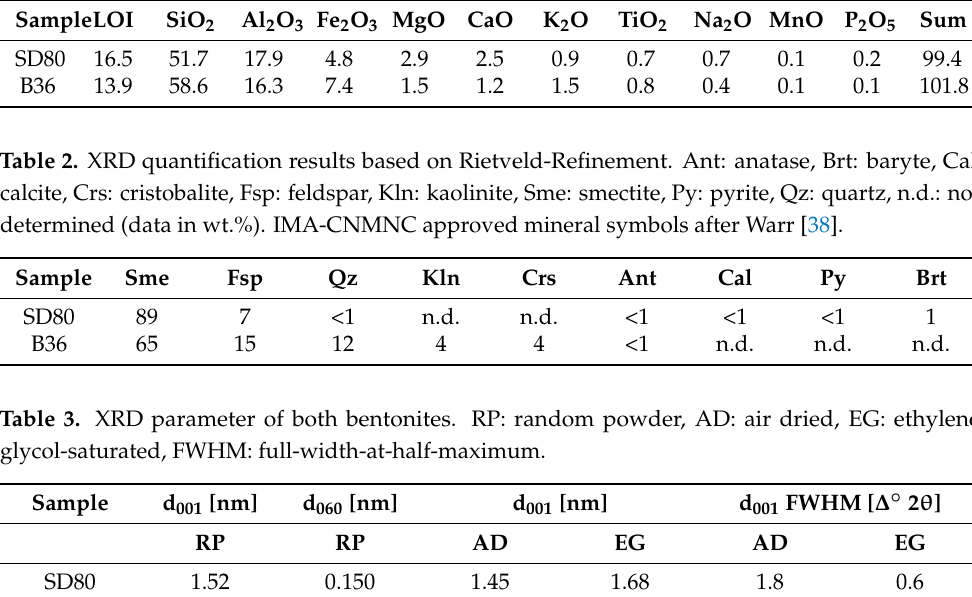
Table 1. XRF main elemental composition of the bulk material (data in oxide wt.%). LOI: loss-on-ignition.